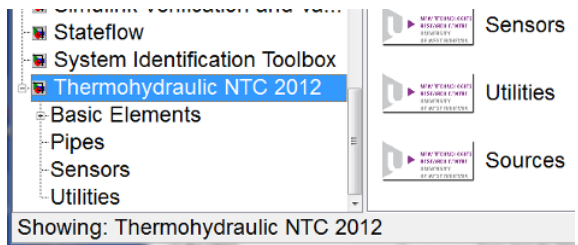
Fig. 2. Thermohydraulic NTC 2012 library in Simulink environ-